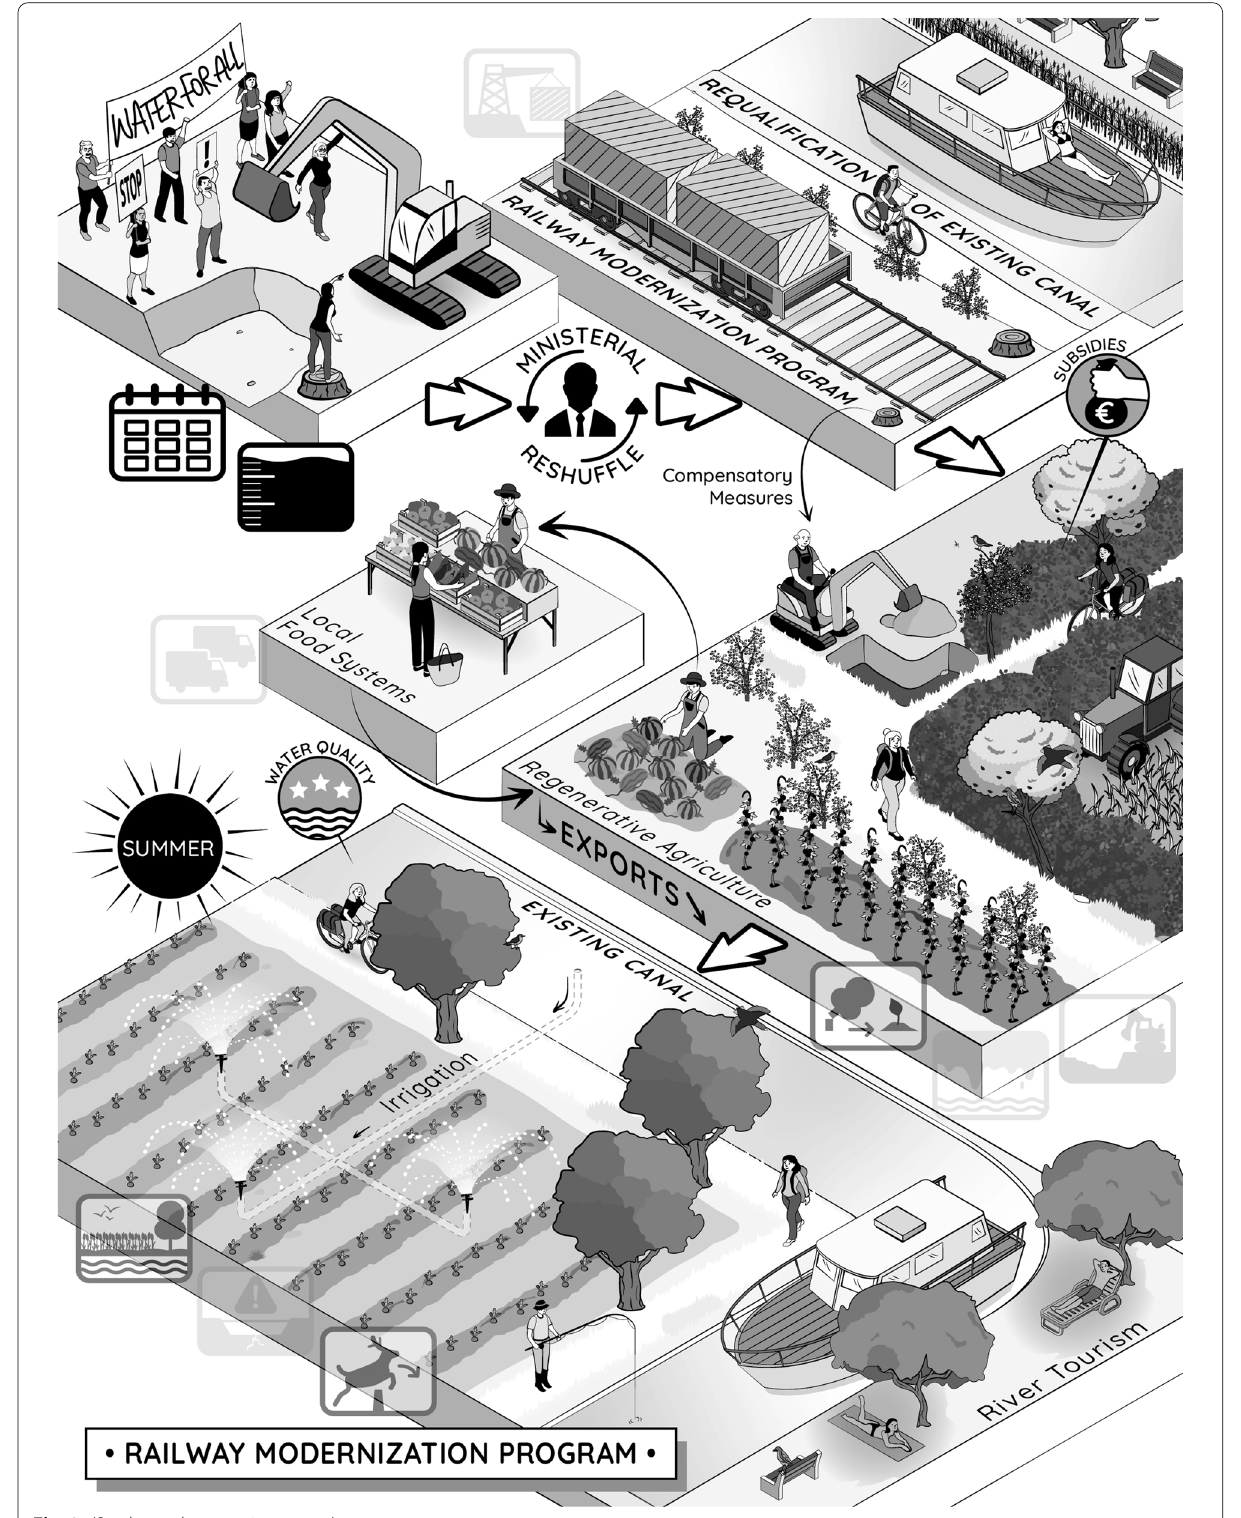
Fig. 3 (See legend on previous